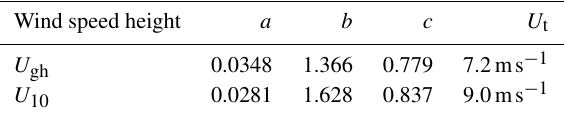
Table 1. Coefficients a , b , and c used in Eq. (1) specified for a single Alter Shield gauge with wind speed measured at gauge height ( U gh ) and at 10m ( U 10 ) (from Kochendorfer et al.,